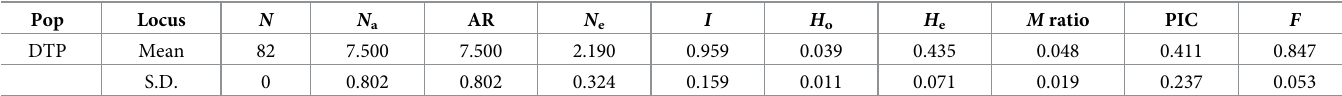
Table 1. Genetic diversity among 82 Hume’s pheasant ( Syrmaticus humiae , Hume 1881) individuals based on 12 microsatellite